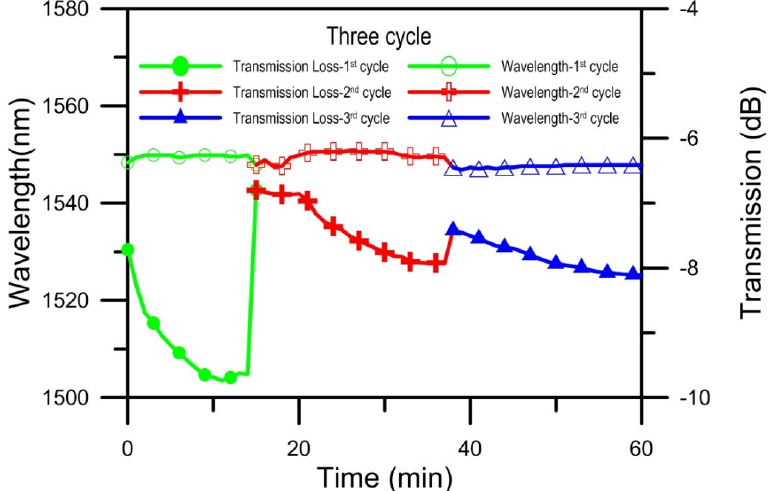
Figure 5. Repeatability of the CO 2 gas sensor.